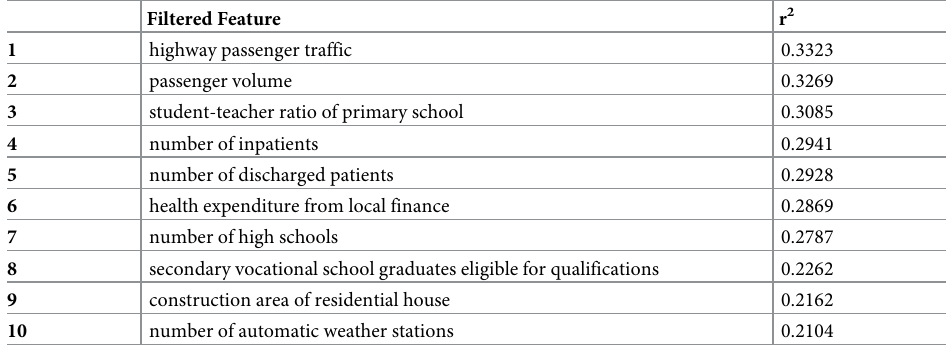
Table 4. Top 10 high scoring features for r 2